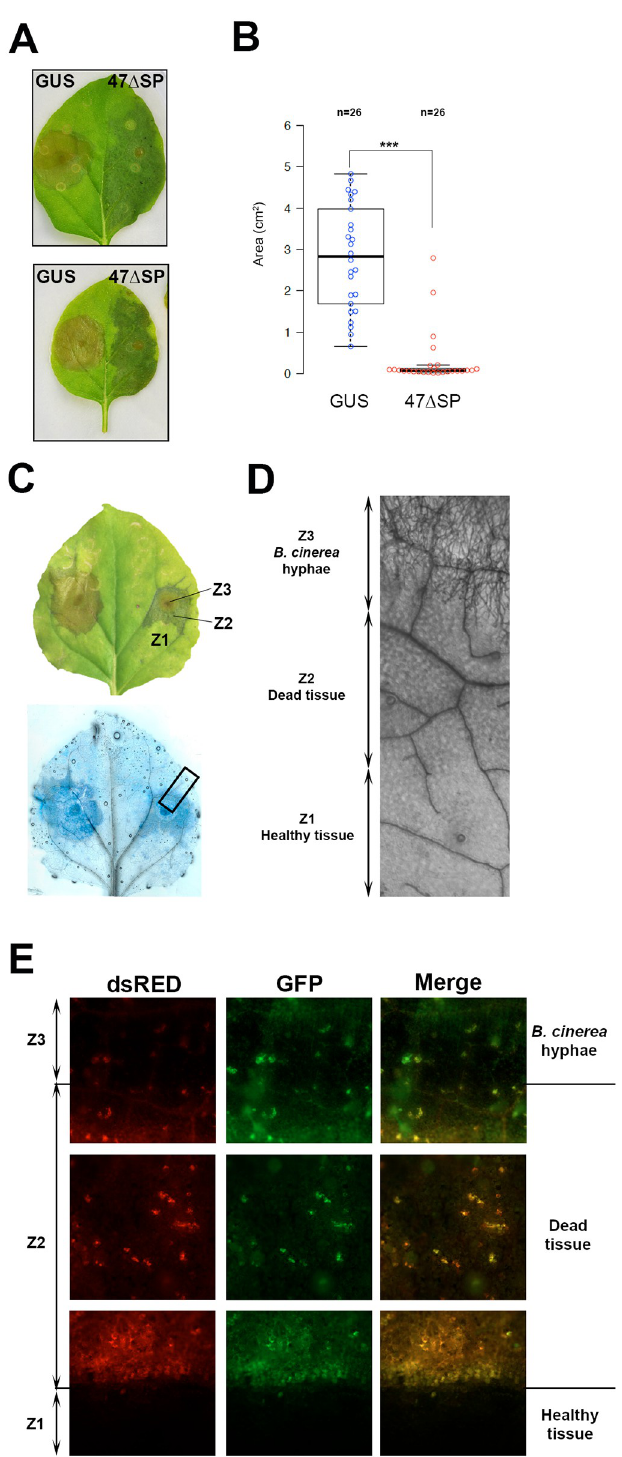
Fig 4. Pvit47 expression in N . benthamiana hinders B . cinerea infection. The two halves of N . benthamiana leaves were infiltrated with A . tumefaciens strains carrying constructs for GUS (negative control) or Pvit47 Δ SP (47 Δ SP) and 2 days later B . cinerea was inoculated by depositing a drop of a spore suspension. (A) Representative images of leaves at 4 dpi. (B) Quantification of lesion size at 4 dpi as necrotic area. Results pooled from three independent experiments. ( ��� ) indicates statistical significance at p < 0.001 in a two-tailed T-test for mean comparison. (C) Daylight image and